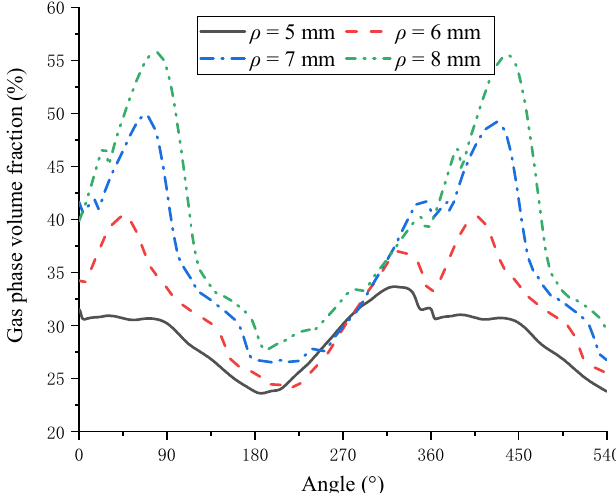
Figure 12. Gas ‐ phase volume fraction at different rotation radii.